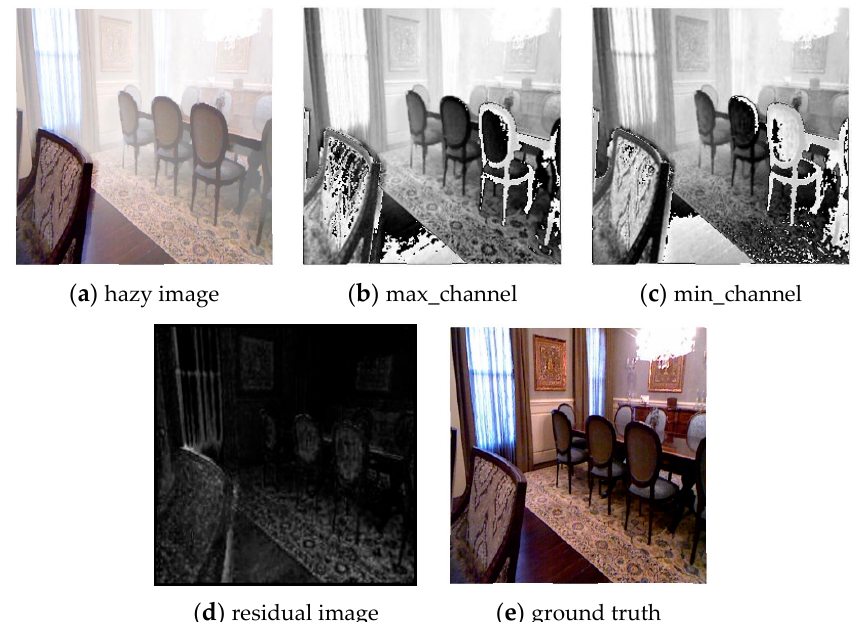
Figure 3. Intermediate results of the decomposition process.